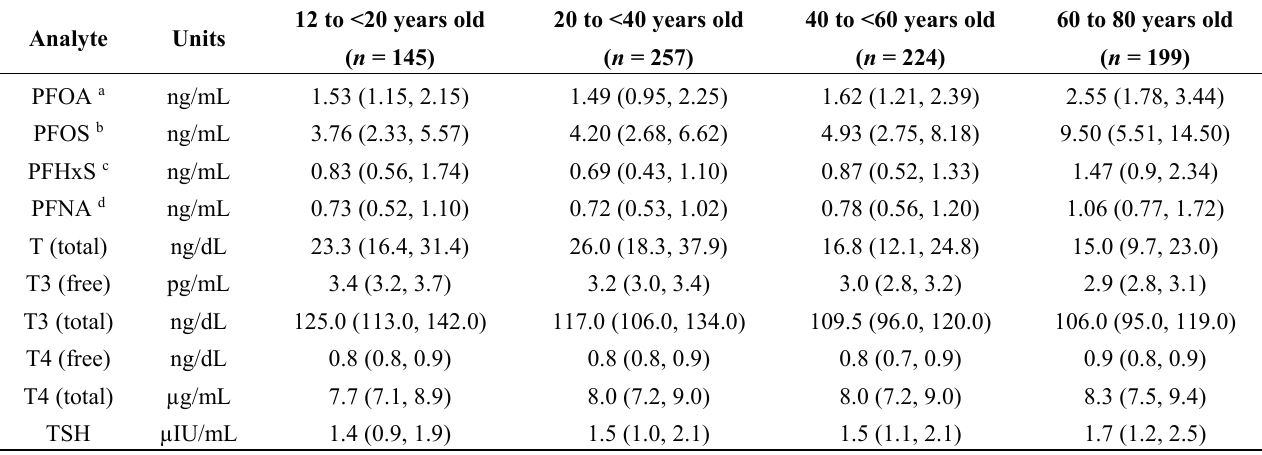
Table 3. Median (25th percentile, 75th percentile) serum concentrations of PFASs and hormones among females from NHANES